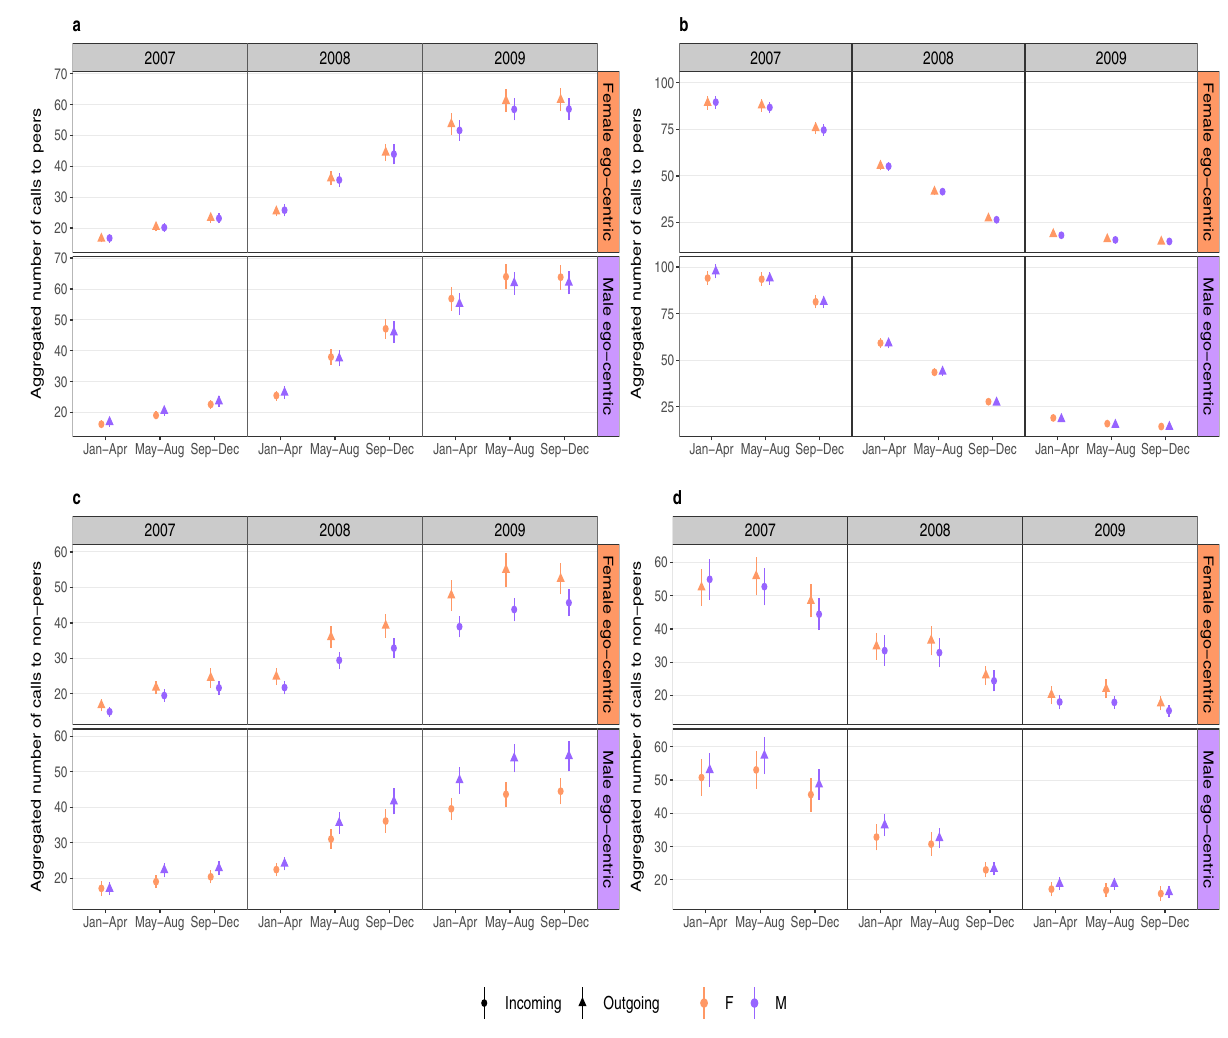
Figure 4. Calling activities of adult (25–35 year old) cohorts between peers and non-peers and having interactions with their opposite genders. The aggregated calls over four-month intervals over a span of three years have been calculated for the opposite-gender friendships for peers (having age differences of less than 10 years) exhibiting ( a ) formation of close bonds and ( b ) decaying of close bonds. We also show the aggregated calls of the young age cohorts calling their non-peers (having age differences of 20 to 40 years) for formation ( c ) and decay ( d ) of close bonds. The orange/violet coloured panels on the right of each of the graphs represent the calls made in a female/male egocentric network. In all the graphs, filled circles/triangles represent incoming/outgoing calls and orange/violet coloured shapes indicate calls initiated by female/male egos in the egocentric networks. Therefore, an orange coloured triangle indicates calls made by females to males while violet coloured circles represent calls made by males to females in a female egocentric network. Similarly, orange coloured circles and violet coloured triangles indicate female-initiated and male-initiated calls in a male-egocentric network. The female-initiated calls in both male and female egocentric networks in the year 2009 show systematically higher values than male-initiated calls in the case of formation of close relationships between peers while there is not much difference visibly between them in decaying relationships. We also find that younger cohorts are more active than their older cohorts in terms of calling activities since they initiate distinctly more number of calls than their older counterparts when forming a close bond. For decaying relationships, we do not find much difference in the calling activities of both genders in female egocentric networks but in the male egocentric network we find that male initiated calls are slightly more female initiated